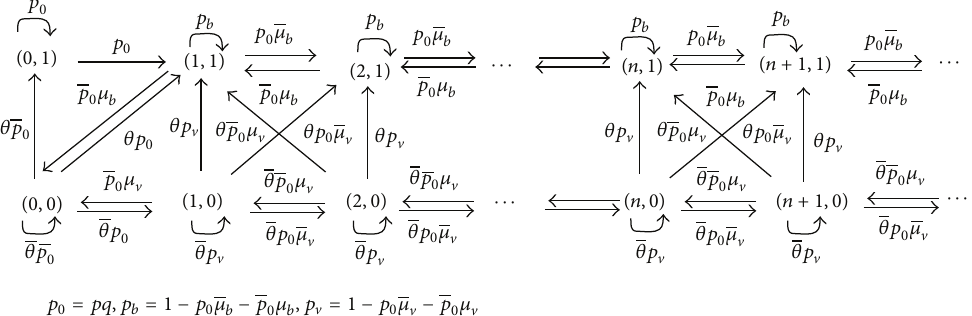
Figure 2: Transition probability diagram for the 𝑞 mixed